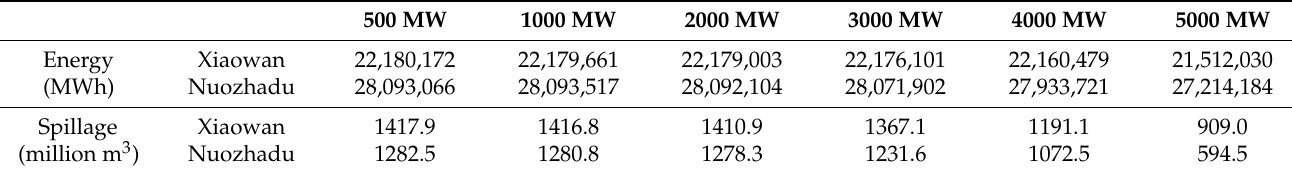
Figure 6. The average energy production of Xiaowan ( a ) and Nuozhadu ( b ) in each Xun (1/3 month) under different power yields for the cascade. Table 4. Annual energy and spillage under different power yields by the SDP-3.